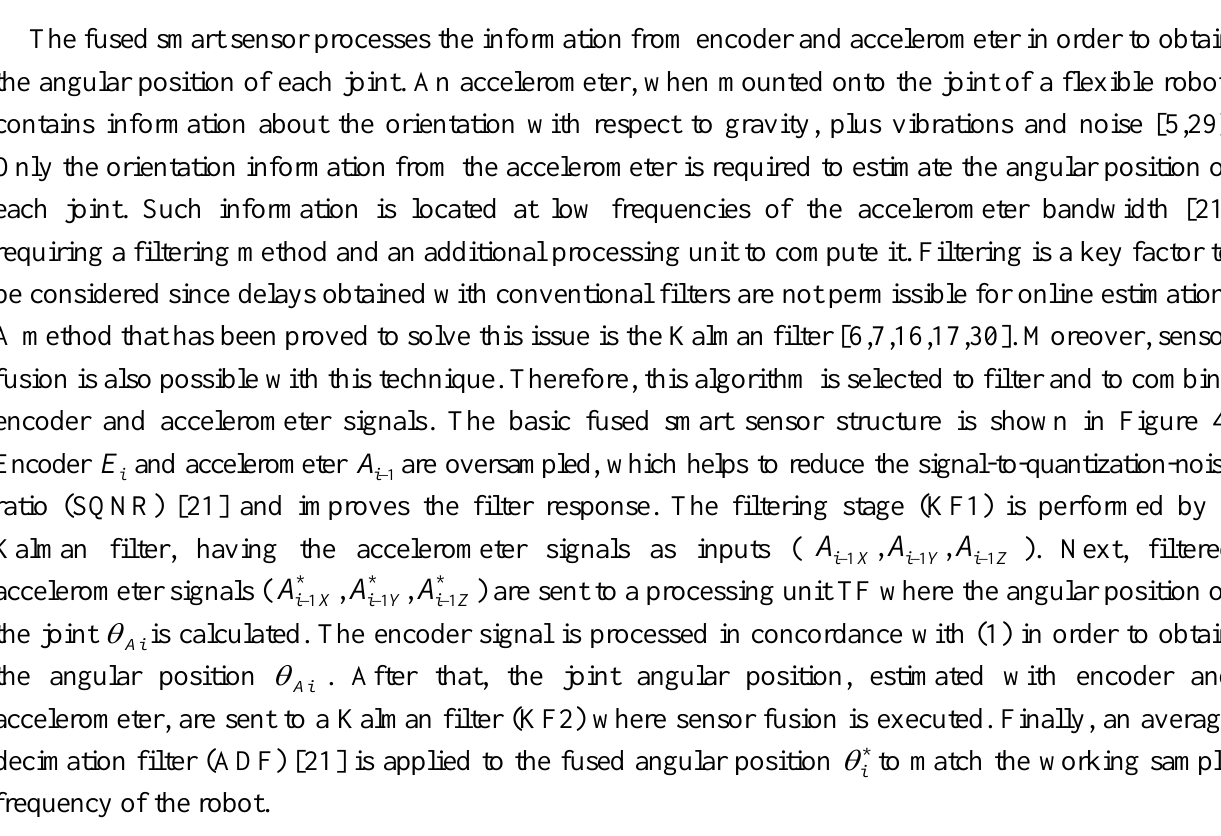
Figure 4. Basic fused smart